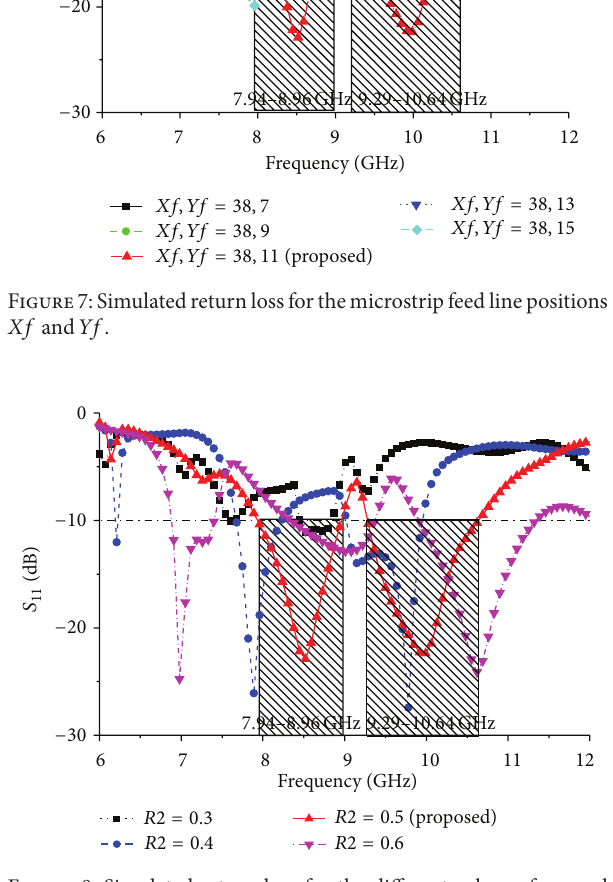
Figure 6: Simulated return loss of different values of feed width 𝑊𝑓 .